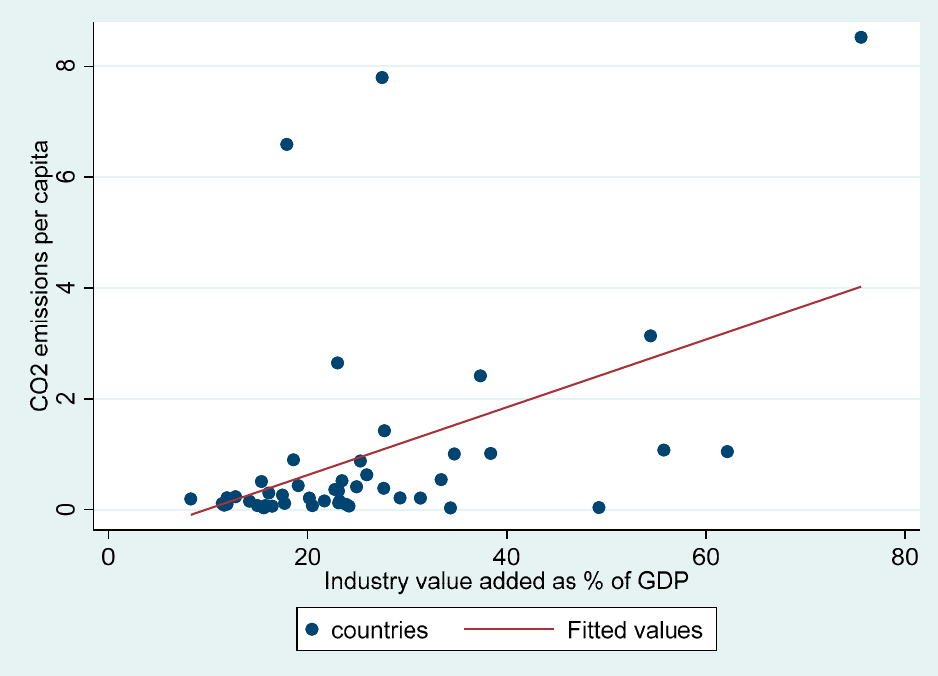
Figure 2. CO2 emissions and industrialization in Sub-Saharan Africa, 2000-2015.